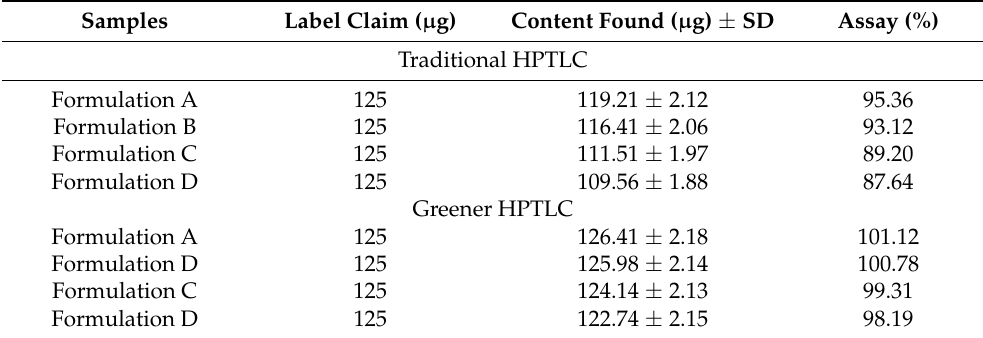
Table 6. Application of traditional and greener HPTLC strategies in the estimation of VD3 in commercial tablets A–D.